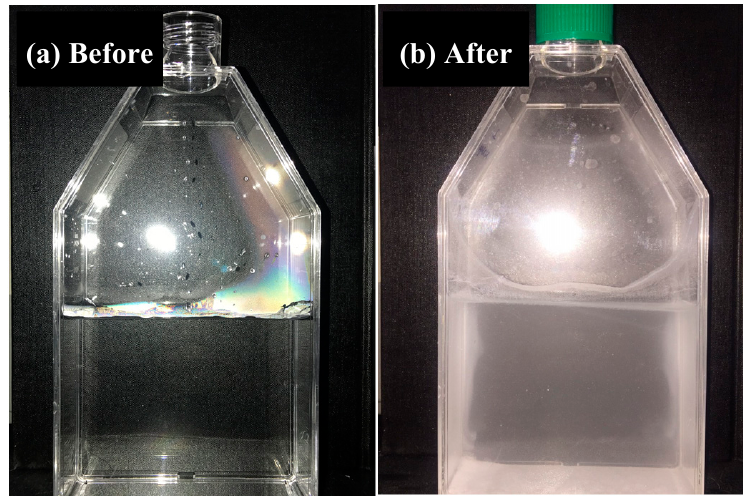
Figure A3. ( a ) The KSTM-SW leachate and ( b ) the leachate after CaCO 3 precipitation.